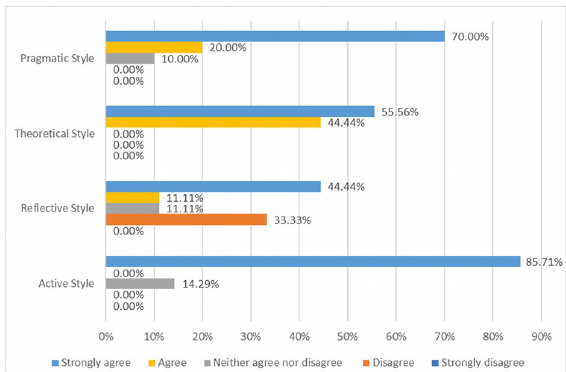
Figure 4. My interactions with my classmates during class are more frequent and